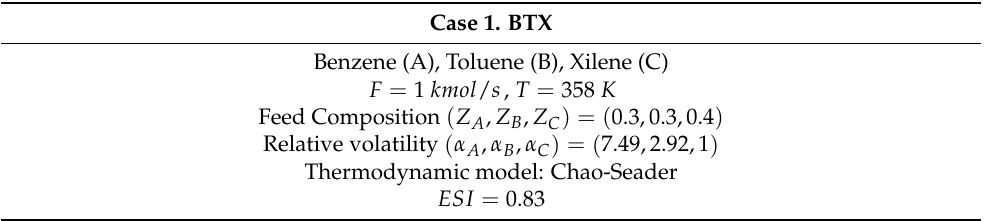
Table 1. Description of the case